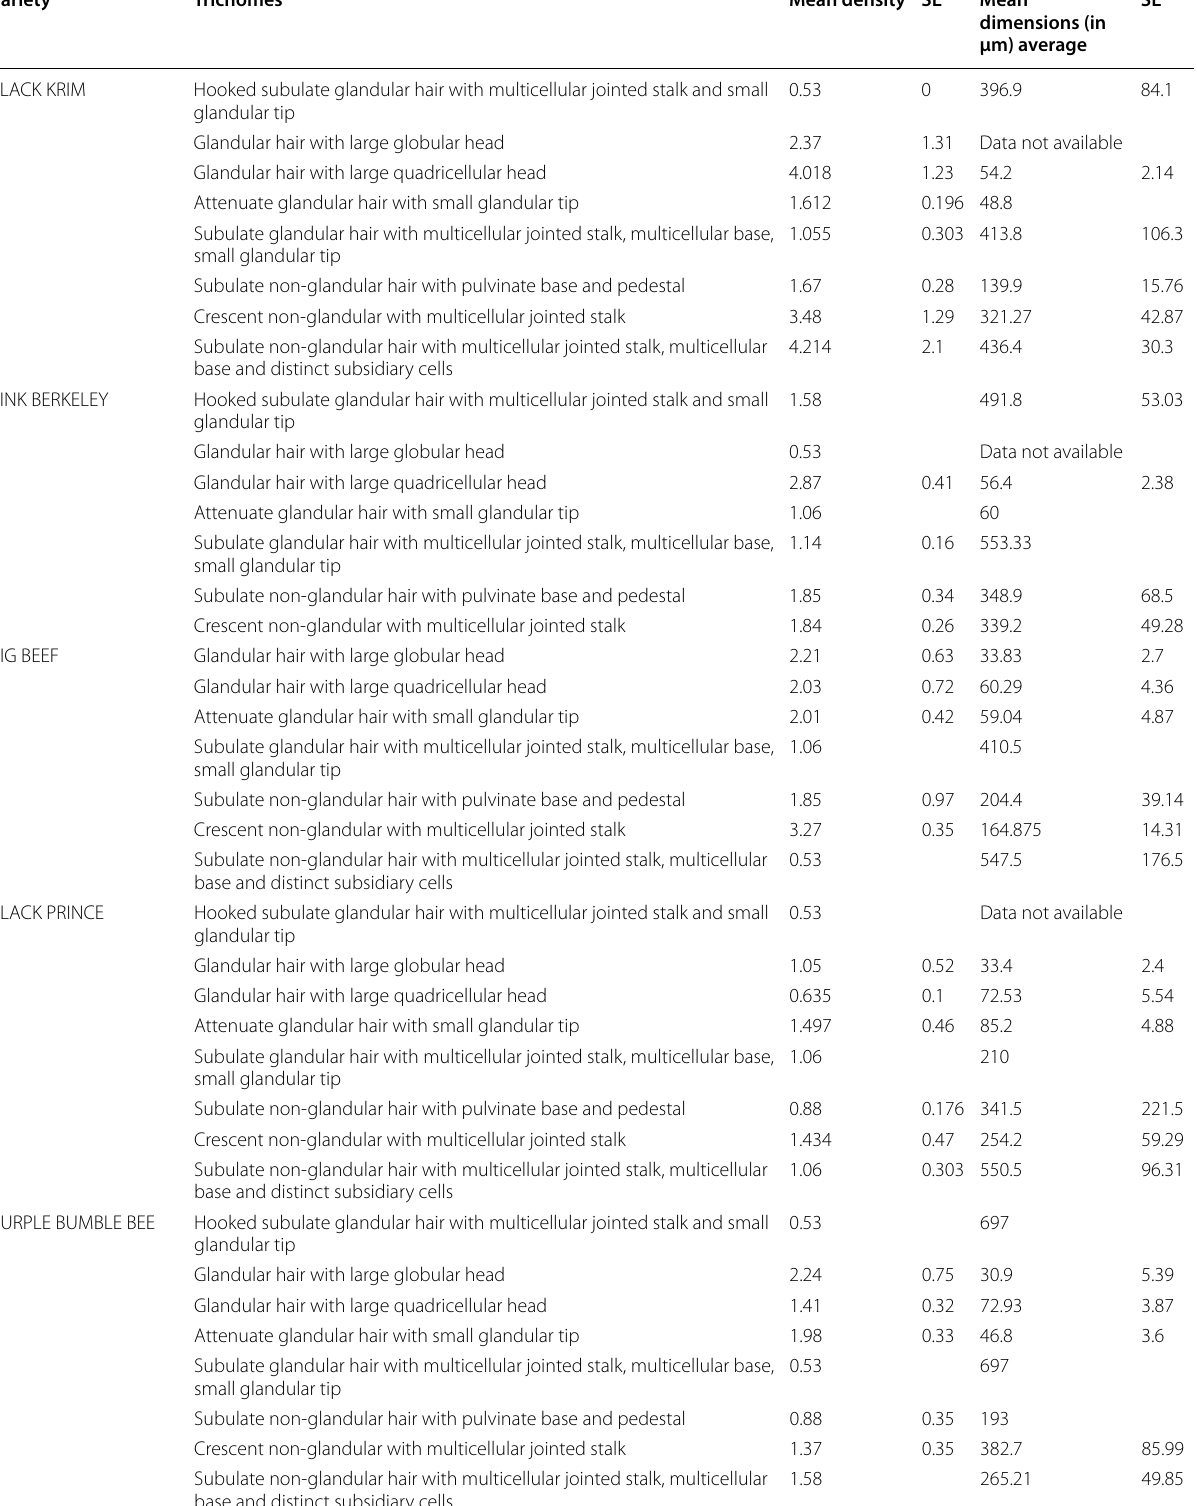
Table 1 The density and dimensions (in µm) of trichomes in ten varieties of tomato Variety Trichomes